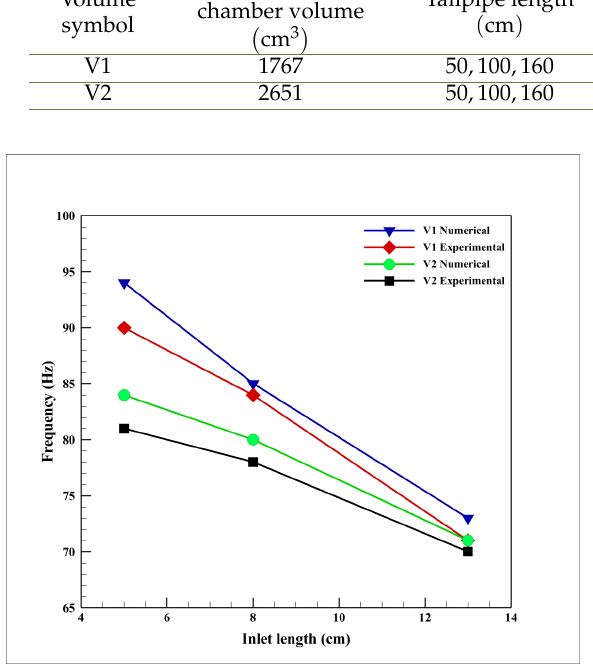
Fig. 5. Variation of frequency with inlet pipe length for V1 and V2